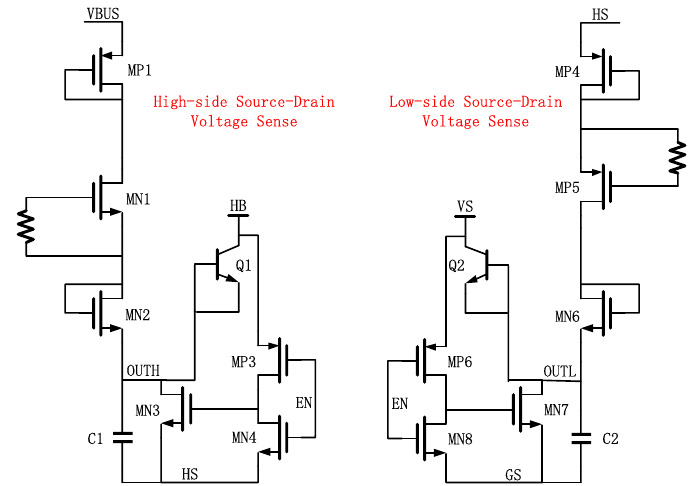
Figure 5. Source-Drain Voltage Sense.